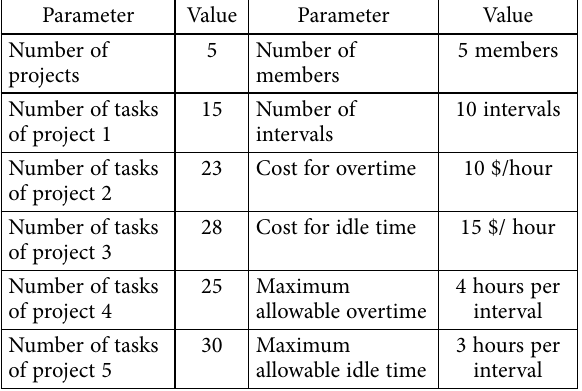
Table 4. The project tasks and main resources